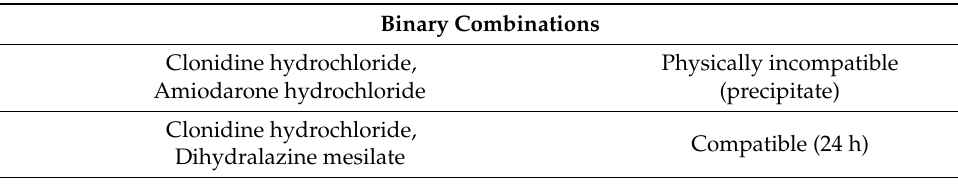
Table 3. Physicochemical compatibility of